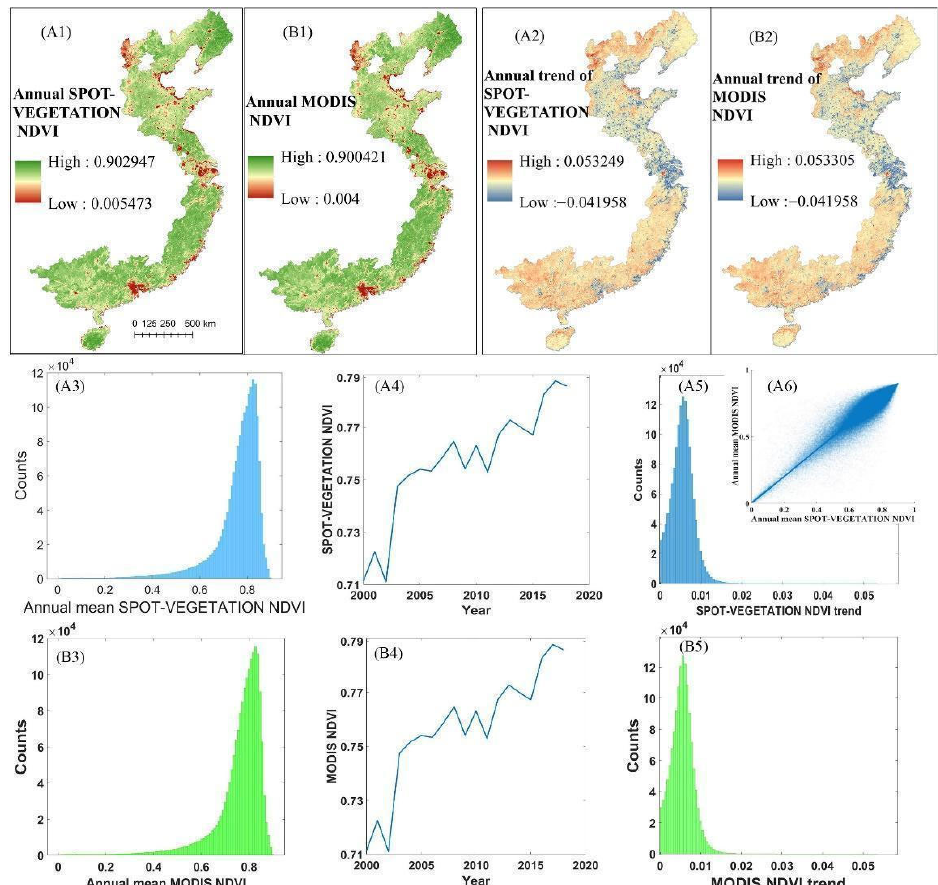
Figure 2. Spatio-temporal pattern and heterogeneity of vegetation dynamics. ( A1 ) represents the annual SPOT-VEGETATION NDVI from 2000–2019; ( B1 ) shows the annual MODIS NDVI from 2000–2019; ( A2 ) represents the annual trend of SPOT-VEGETATION NDVI; ( B2 ) represents the annual trend of MODIS NDVI; ( A3 ) shows frequency distribution histogram for A1 ; ( B3 ) shows frequency distribution histogram for B1 ; ( A4 ) shows annual changes of SPOT-VEGETATION NDVI across entire coastal China from 2000 to 2019; ( B4 ) shows annual changes of MODIS NDVI across entire coastal China from 2000 to 2019; ( A5 ) is the frequency distribution histogram for A2 ; ( B5 ) is the frequency distribution histogram for B2 ; and ( A6 ) shows the scatter plot of annual mean SOPT-VEGETATION NDVI against MODIS NDVI in pixel